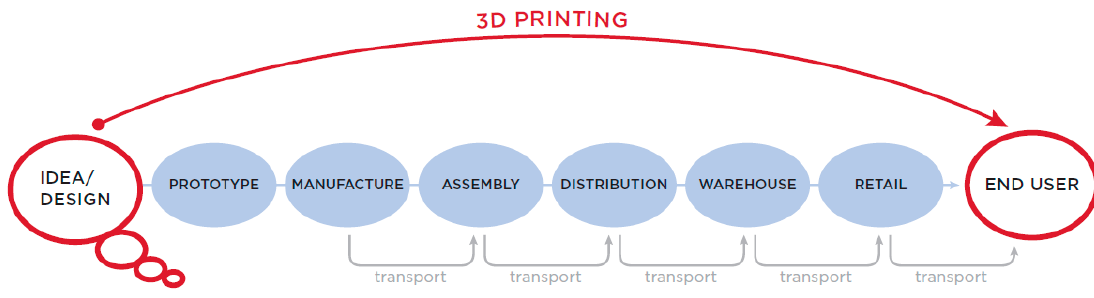
Figure 1. Traditional versus 3D printing supply chain [2].